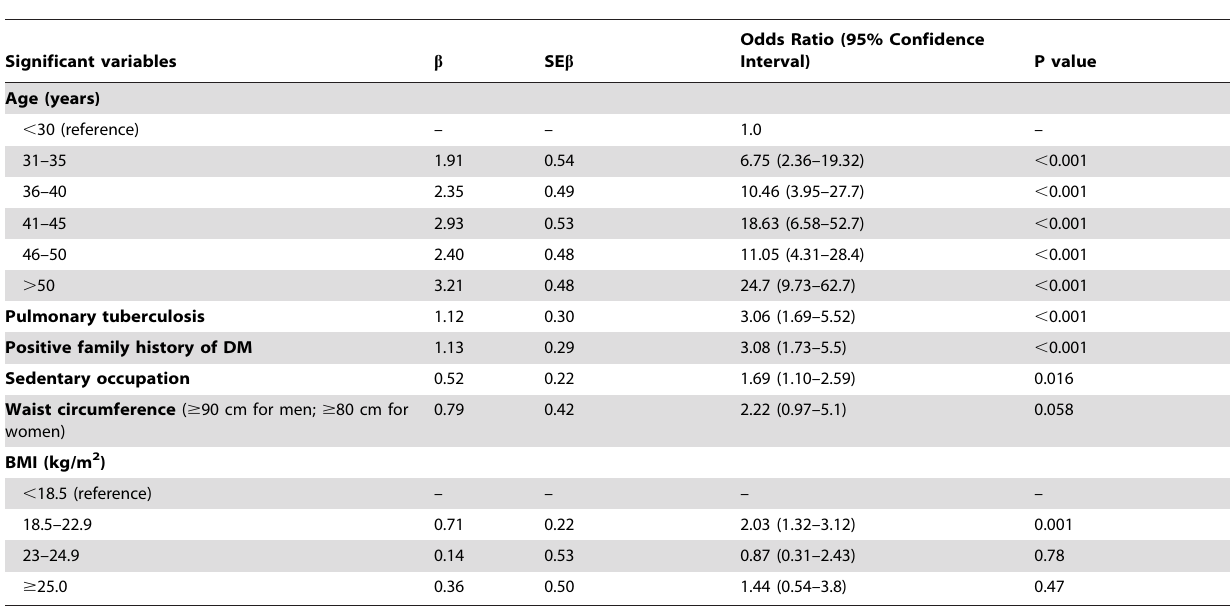
Table 4. Results of multinomial logistic regression analysis (Diabetes vs. Non-diabetes; dependent variable).